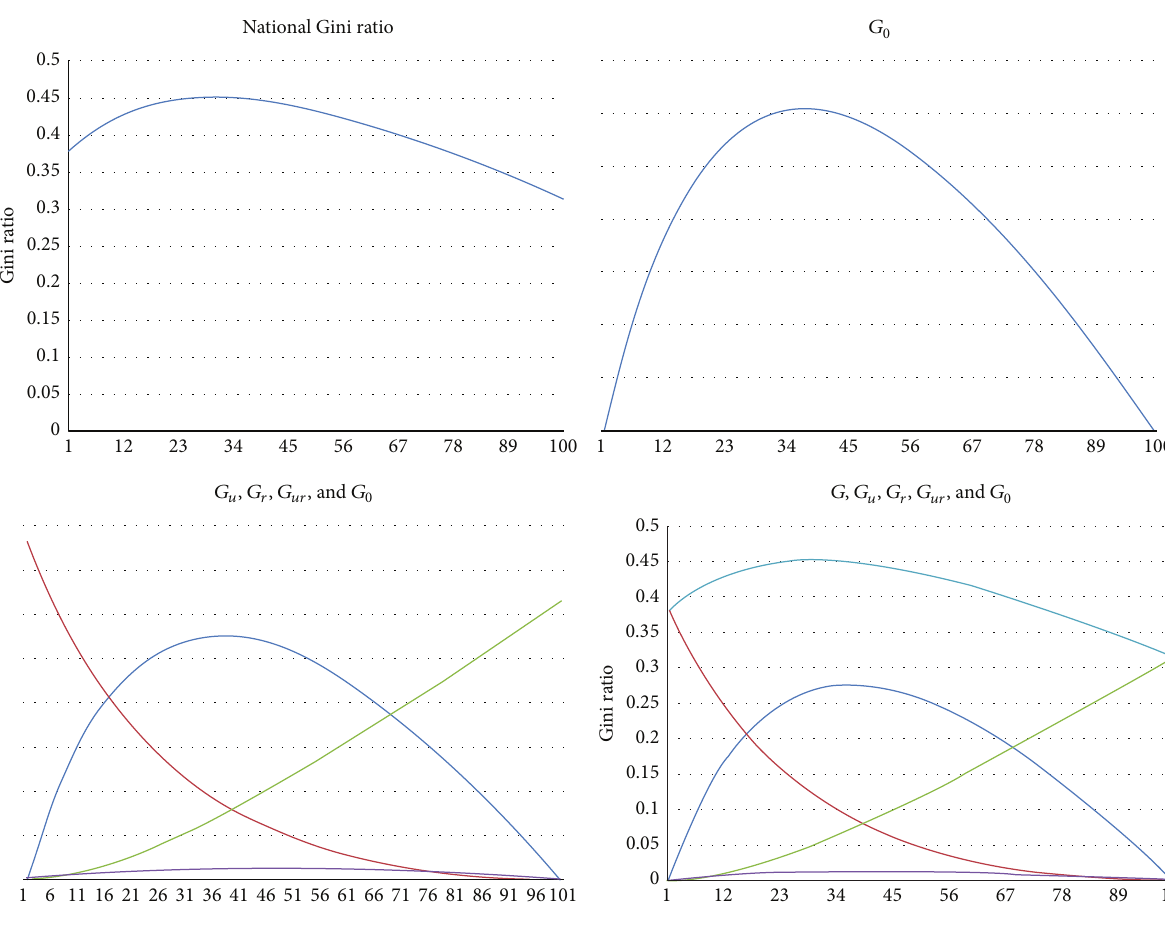
Figure 3: Changes in the national Gini: 𝐺 𝑢 , 𝐺 𝑟 , 𝐺 𝑢𝑟 , and 𝐺 0 .